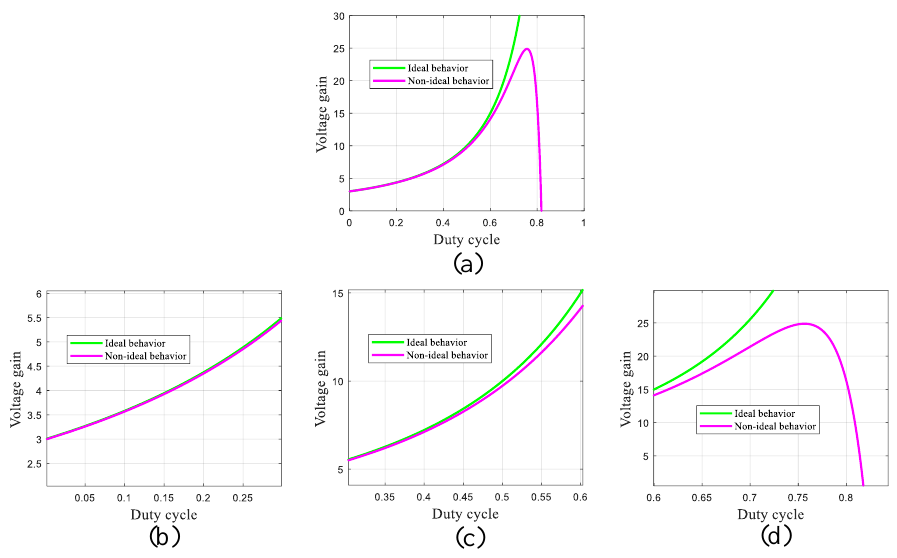
Figure 6. ( a ) Comparing the ideal and non-ideal voltage gains while the duty cycle varies: ( b ) from 0% to 30%, ( c ) from 30% to 60%, ( d ) from 60% to 85%.